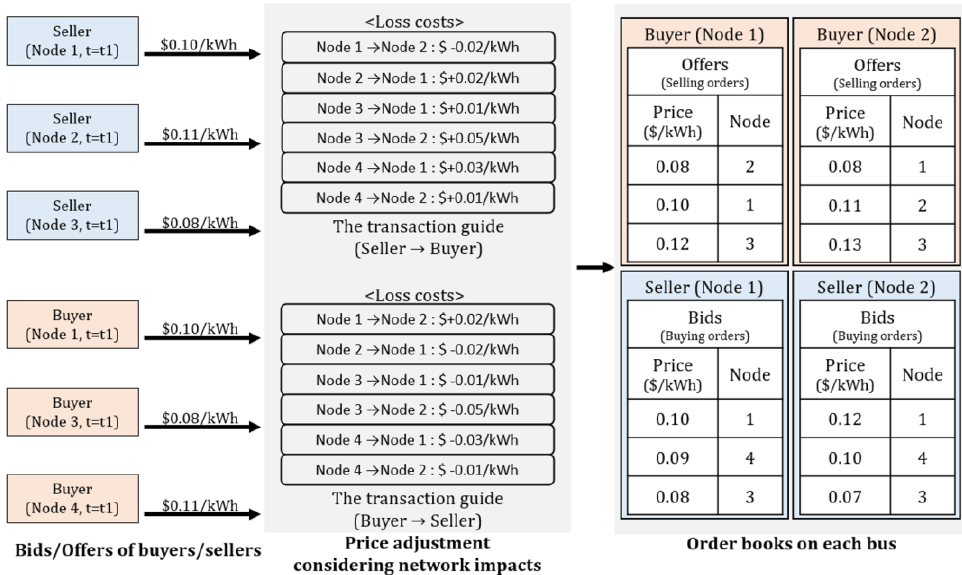
Figure 2. Concept of the matching process using the transaction loss guide.